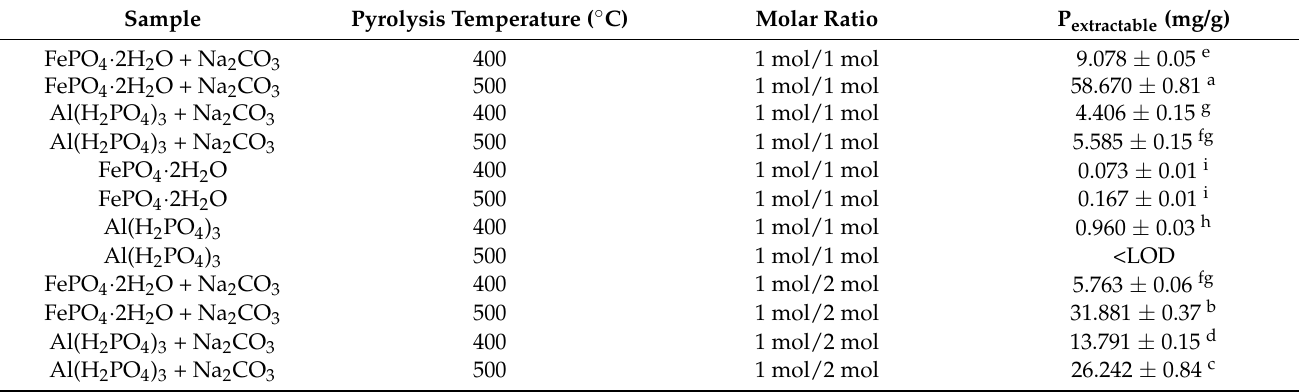
Table 1. Chemical constitution and phosphorus extractability of tested